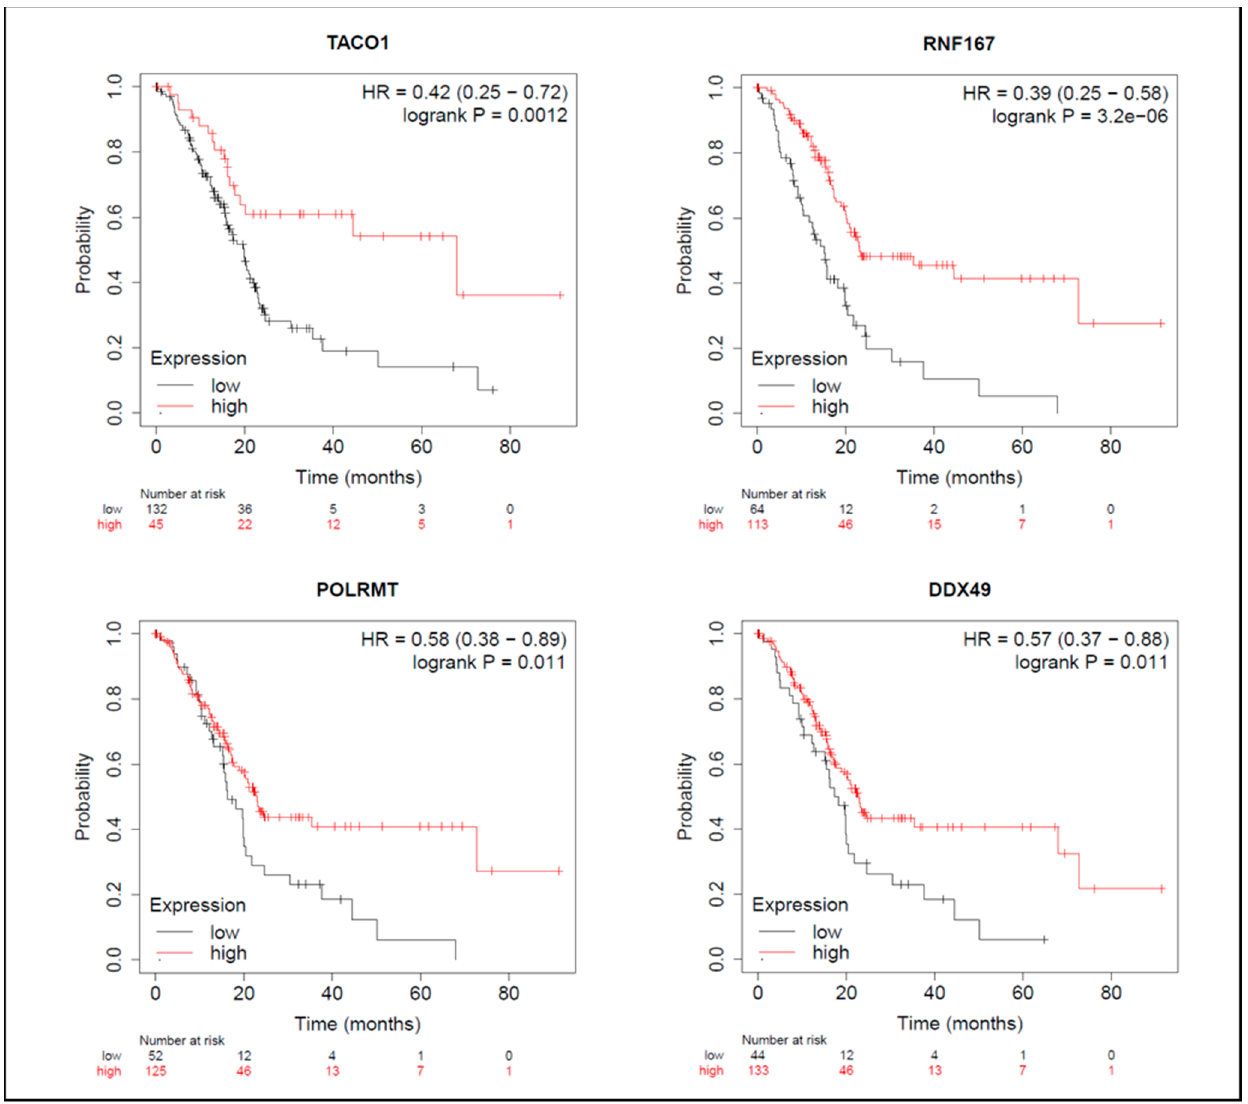
Figure 7. Meta-analysis of betulinic acid (BA)-induced downregulated proteins in overall survival (OS) in pancreatic ductal adenocarcinoma (PDAC) databases of the KM plotter. High expressions of TACO1 ( p = 0.001), RNF167 ( p < 0.001), POLRMT ( p = 0.011), and DDX49 ( p = 0.011) were associated with greater OS.